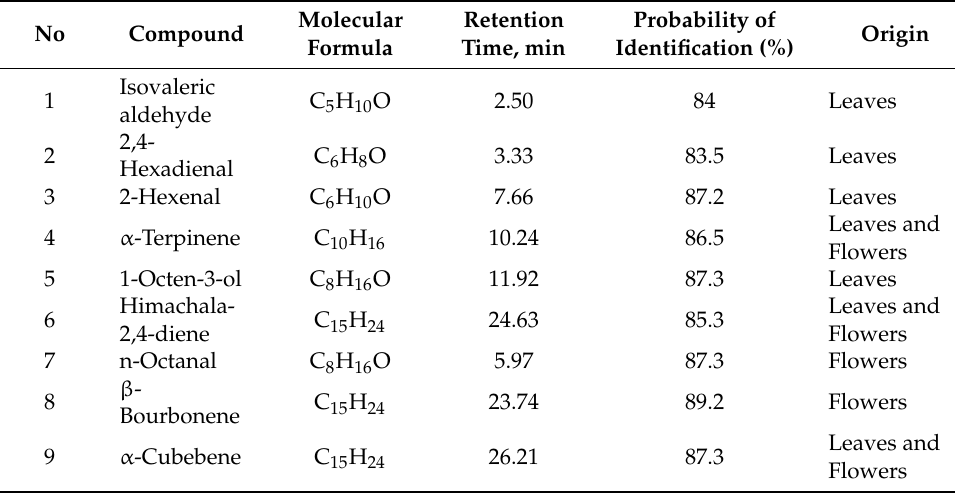
Table 2. Phytochemicals extracted from P. viscosa and identified by GC-MS.